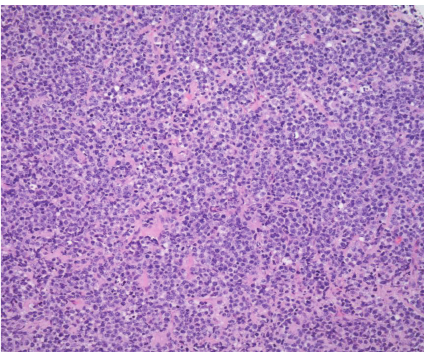
Figure 2: H and E stain of the right atrial biopsy showing sheets of large malignant lymphocytes consistent with